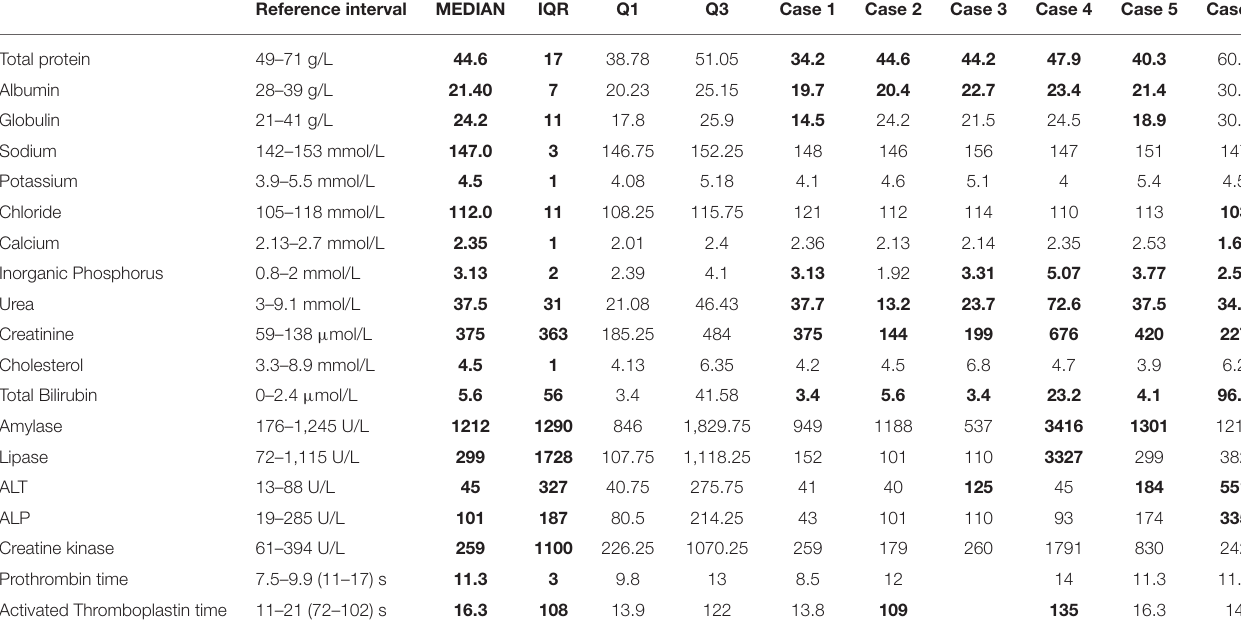
TABLE 1 | Admission serum biochemical and coagulation times for six dogs with cutaneous and renal glomerular vasculopathy at the tertiary referral center. Reference